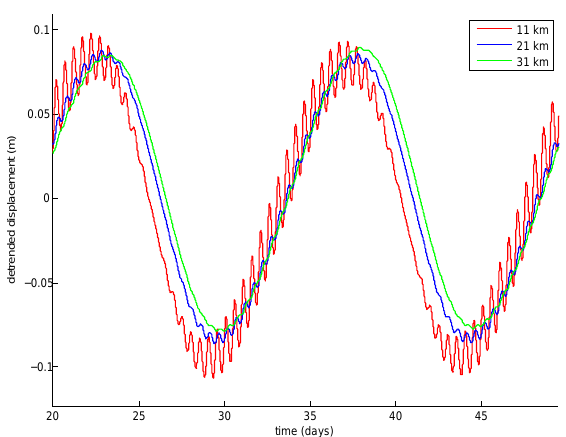
Fig. 5. Linearly detrended horizontal surface displacement. The model was forced with ocean tides using only the S2 and the M2 tidal components, each with an amplitude of 2m. The domain of the finite-element model extended 120km upstream and 50km down- stream from the grounding line, respectively. The geometry of the model was based on a thickness profile running along the medial line of Rutford Ice Stream. At the grounding line ice thickness was 1708m. The average surface slope was 0.003 upstream and 0.001 downstream of the grounding line. For the ice values of the rheo- logical parameters were: A = 10 − 12 d − 1 kPa − 3 , n = 3, E = 1GPa, ν = 0 . 45. For the till: m = 3 and a value of rate factor that gave a surface velocity of about 1md − 1 . Ice and ocean densities were ρ = 917kgm − 3 and ρ w = 1030kgm − 3 ,